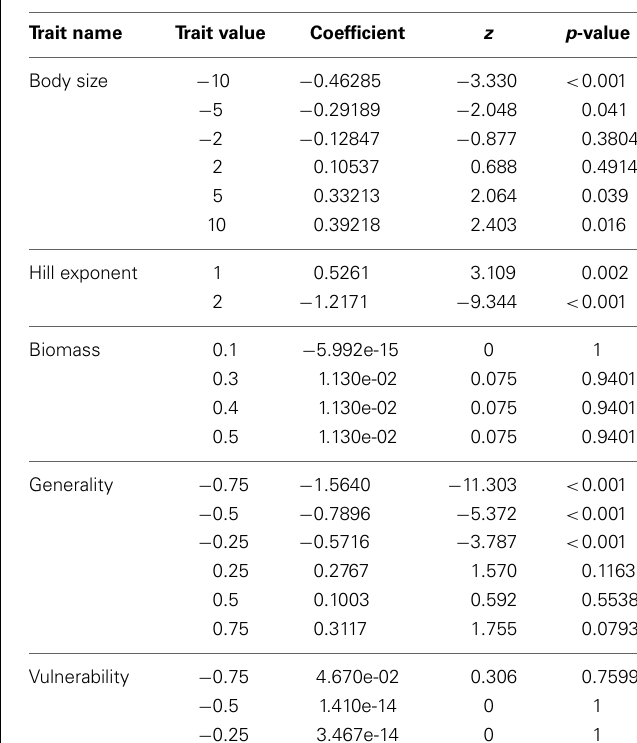
Table 1 | Effects of variation on invader species traits on invasion success.